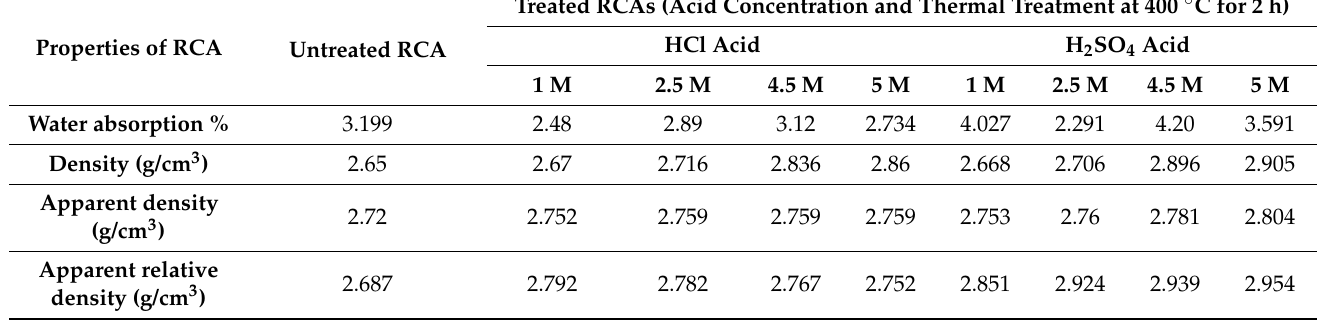
Table 2. Effect of treatment conditions on basic mechanic properties of